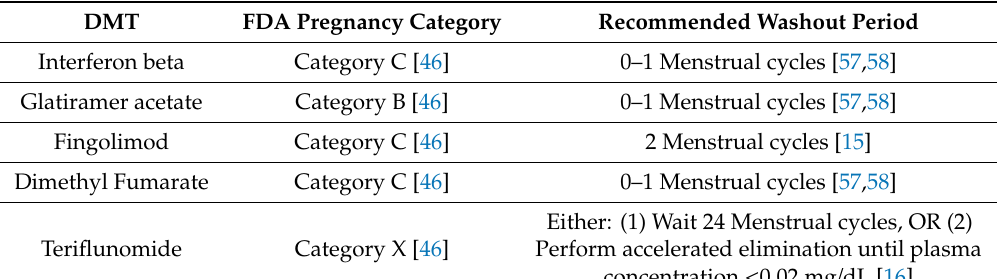
Table 4. FDA pregnancy categories and recommended washout periods for MS